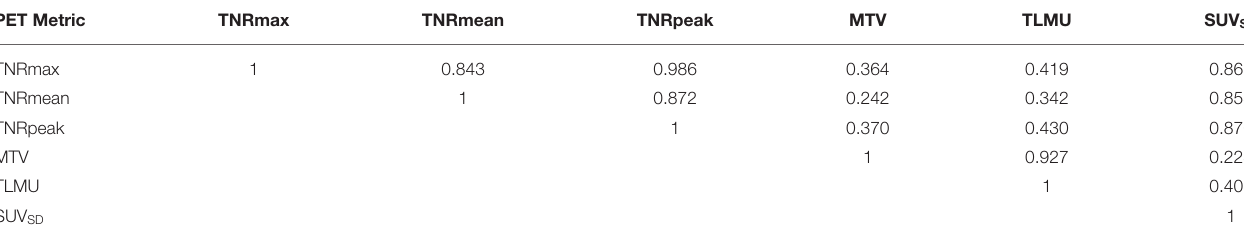
TABLE 3 | Correlation of 11 C-MET PET metrics.